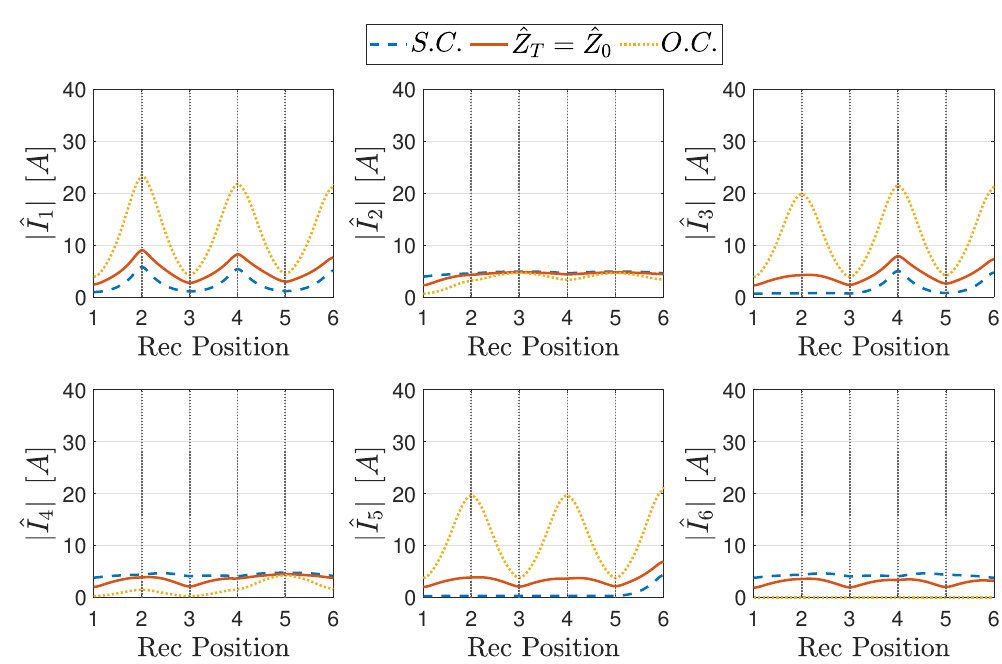
Figure 18. Magnitude of the currents of the array resonators as a function of the receiver position, for different terminations and a receiver load ˆ Z load = 15 Ω .